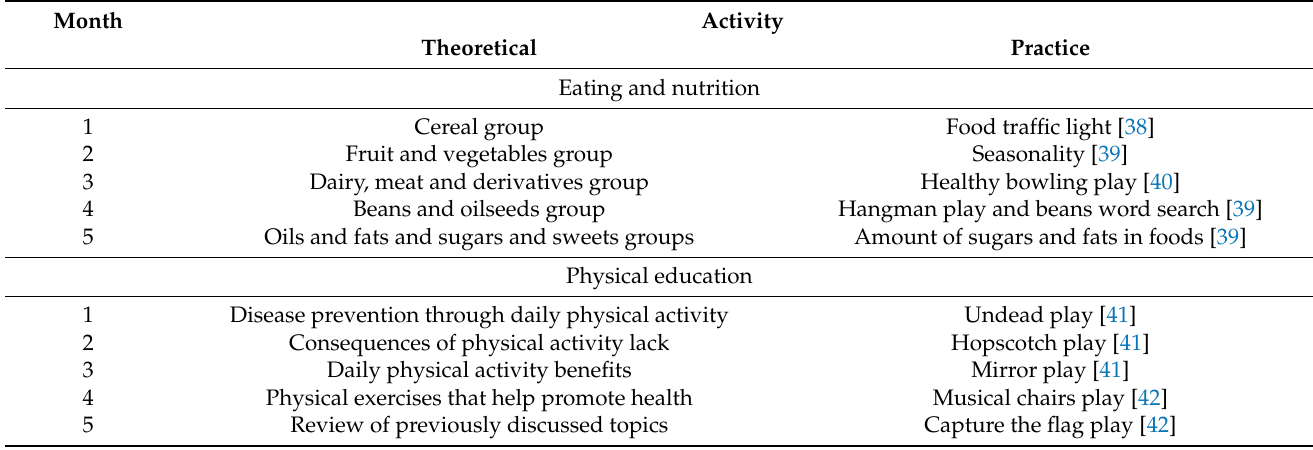
Table 1. Nutrition education and physical activity activities developed in